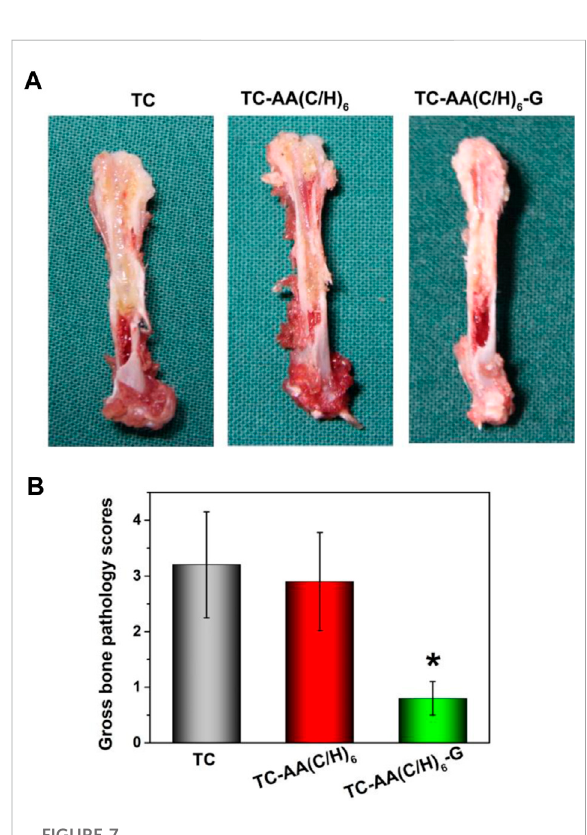
FIGURE 7 -Grossappearanceandscoresoflongitudinalsectionsofthree kinds of femurs. (A) TC and TC-AA(C/H) 6 groups showed signs of purulent infections, while the TC-AA(C/H) 6 -G group showed no obvious infection signs; (B) The score of the TC-AA(C/H) 6 -G group was signi fi cantly lower than other two groups, * p <